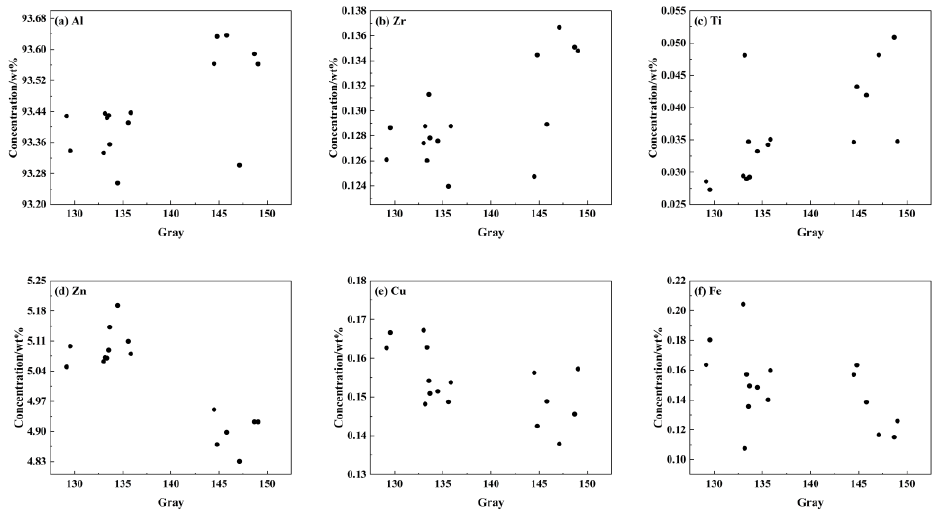
Figure 11. Quantitative relationship diagram between content and microstructure in the 7B05 aluminum alloy. ( a ) Al, ( b ) Zr, ( c ) Ti, ( d ) Zn, ( e ) Cu, ( f ) Fe. aluminum alloy. ( a ) Al, ( b ) Zr, ( c ) Ti, ( d ) Zn, ( e ) Cu, ( f )